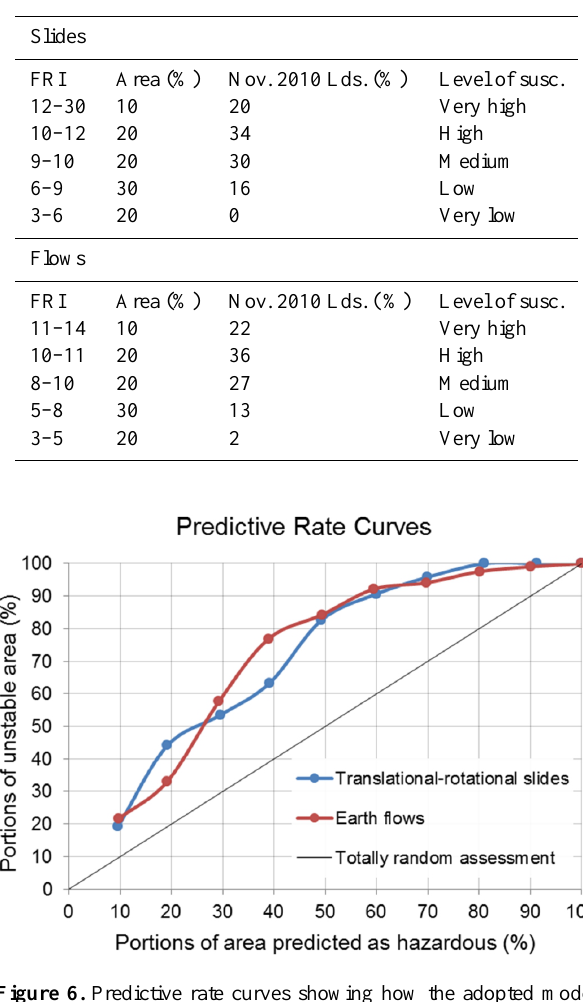
Table 4. Levels of susceptibility assigned on the basis of the degree of prediction of different landslide index ranges.